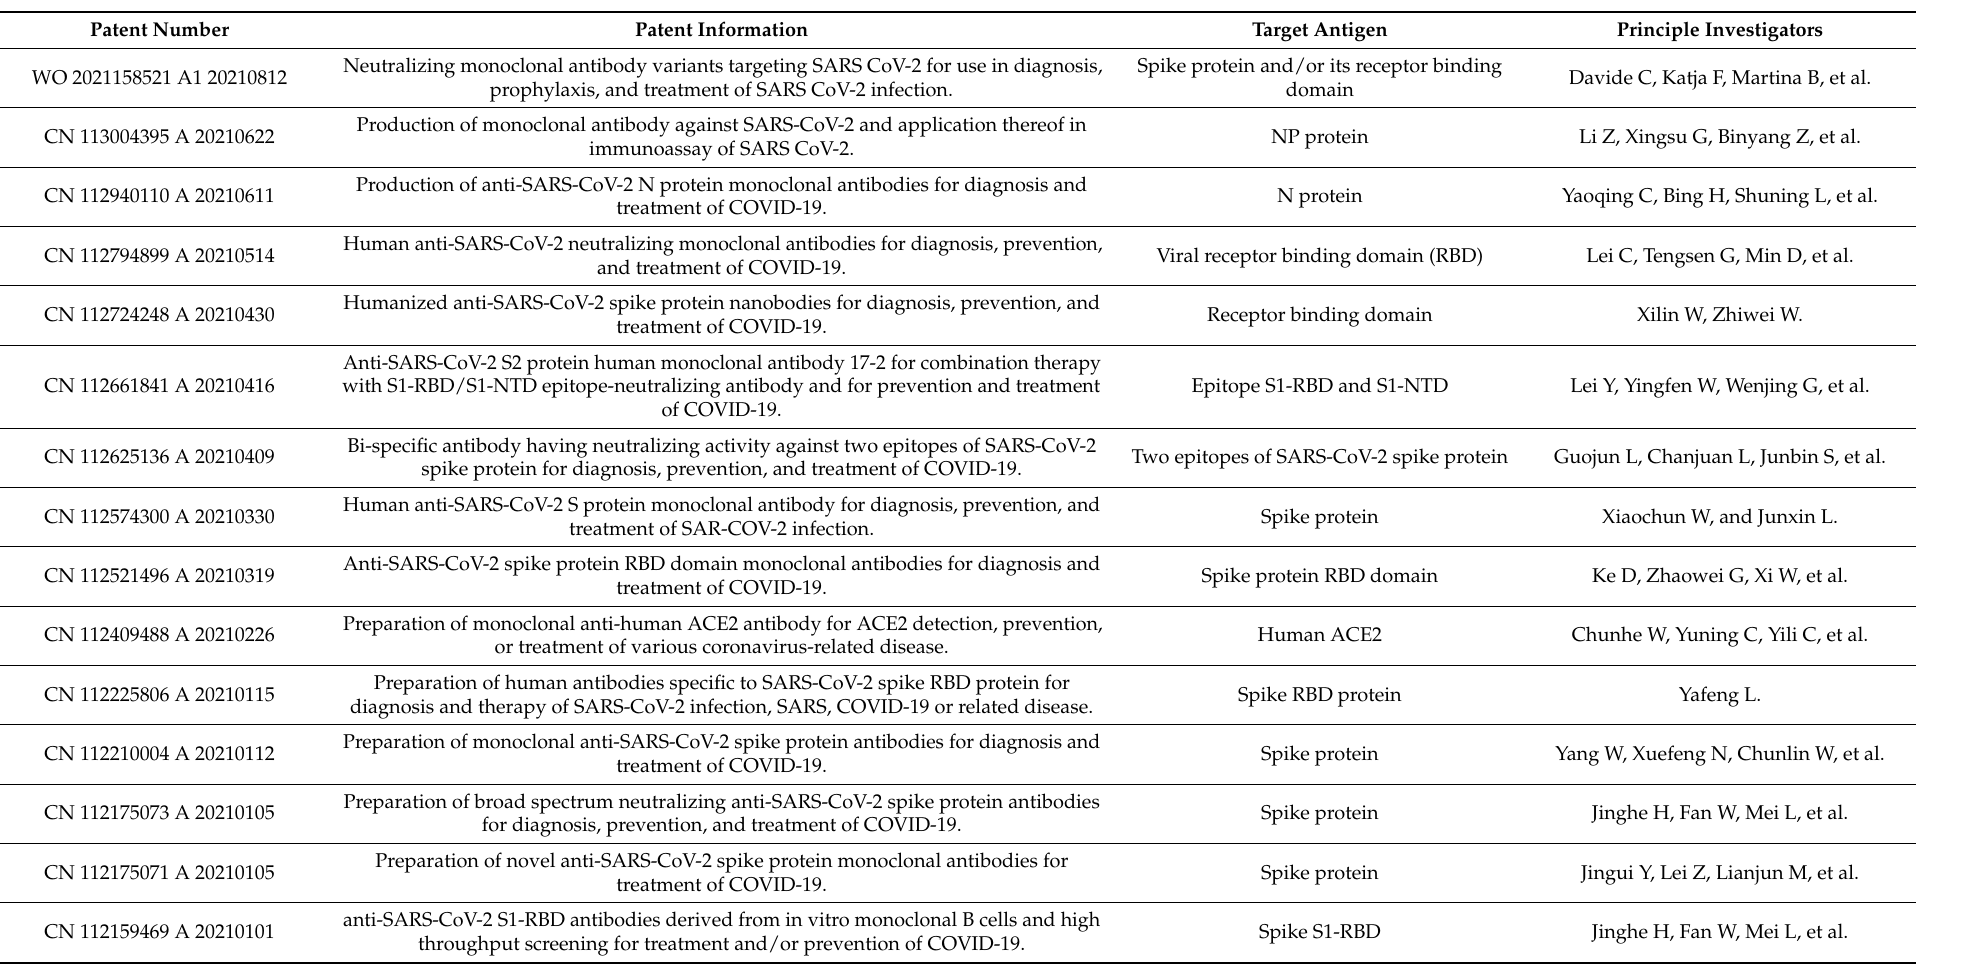
Table 4. List of important patent applications currently filed (2021) for MAbs against COVID-19 in WIPO